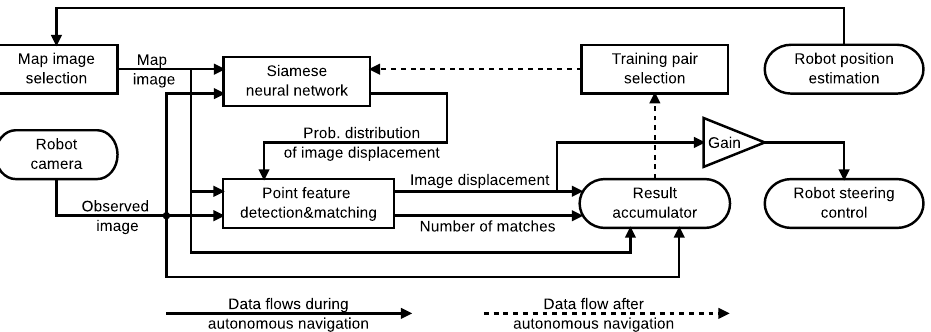
Figure 1. Core part of the proposed ‘visual teach, repeat and learn’ (VTRL) navigation pipeline. The siamese neural network provides priors to the feature matching, which, in turn, provides registration results to train the neural network. This results in gradual improvement of VTR